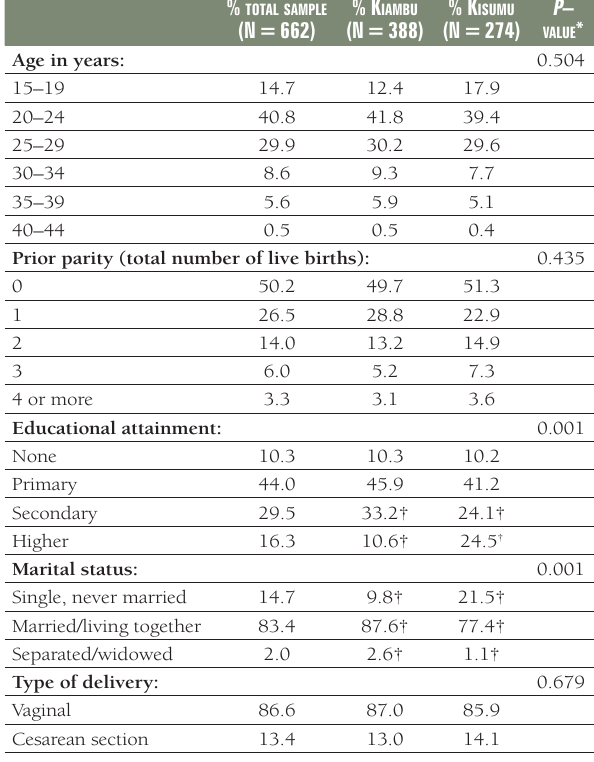
Table 1. Sample background characteristics by facility location % total sample (N =